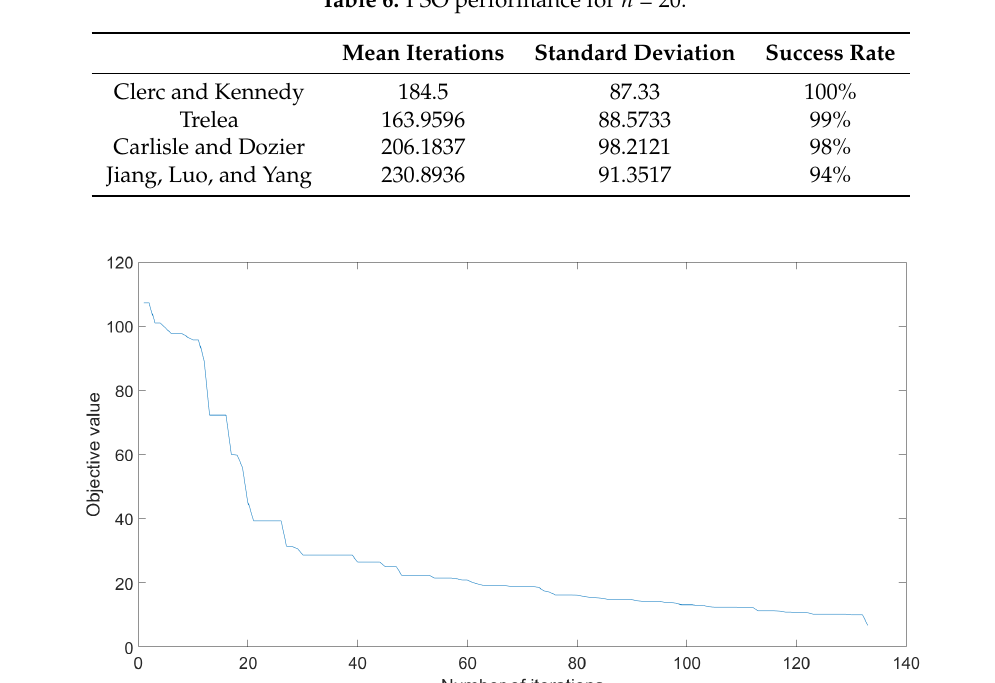
Table 6. PSO performance for n = 20.